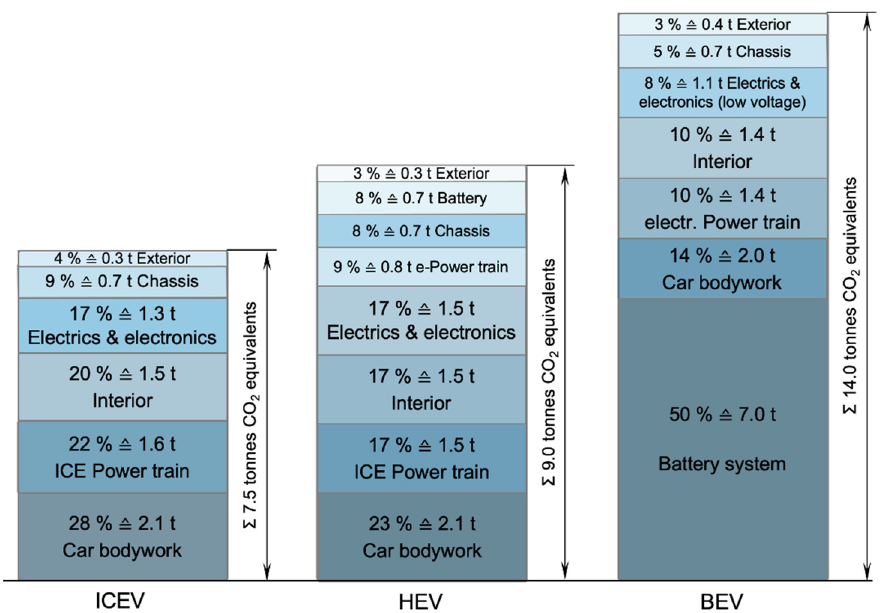
Figure 14. LCA-based production-related CO 2 -equivalent-emission impacts of selected compact cars, equipped with different propulsion technologies.